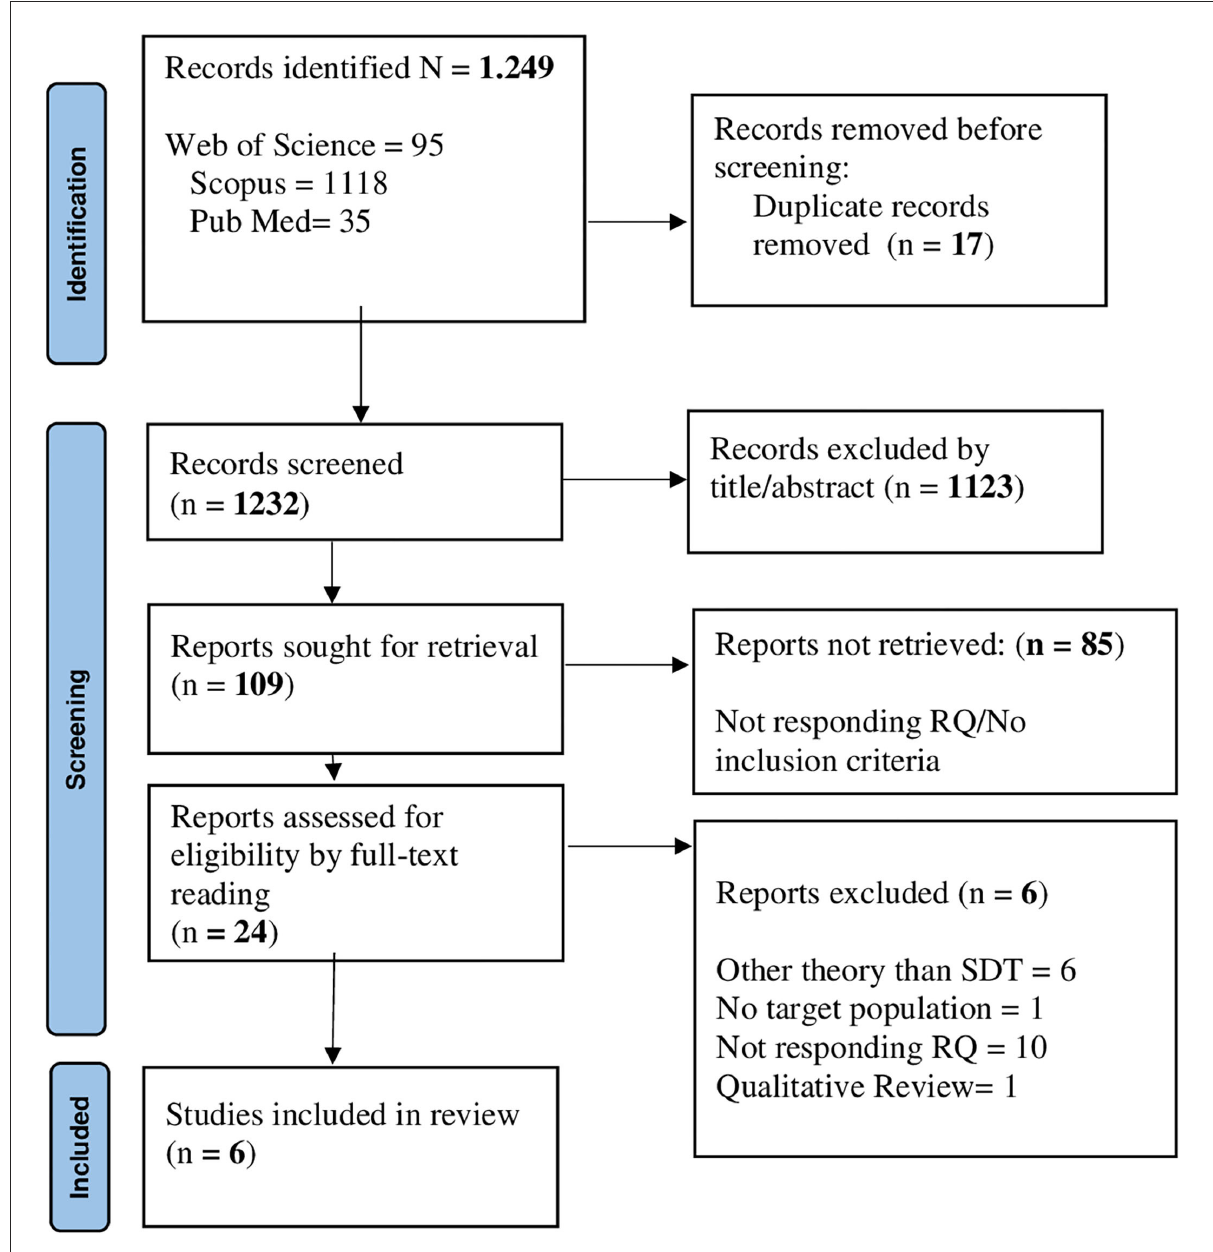
FIGURE1 PRISMA flowchart for the factors are associated with HE students’ emotion regulation.